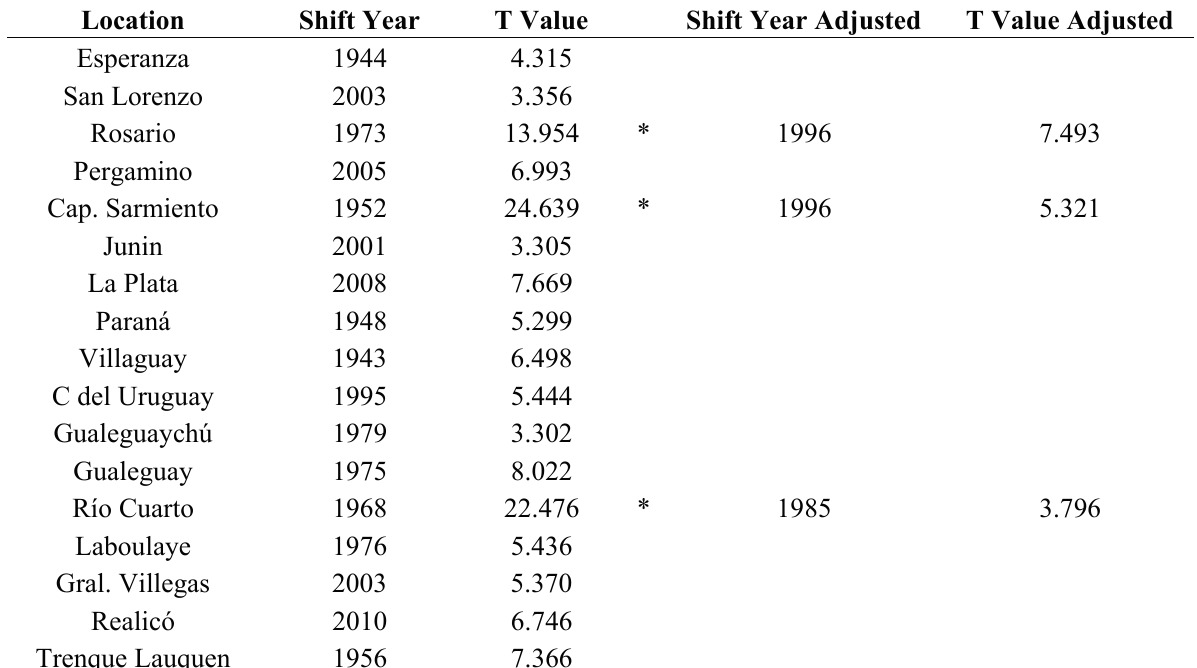
Table 2. Test results of the Standard Normal Homogeneity Test (SNHT) applied to annual precipitation series from the Pampa Region. (* indicates that the T value exceeds